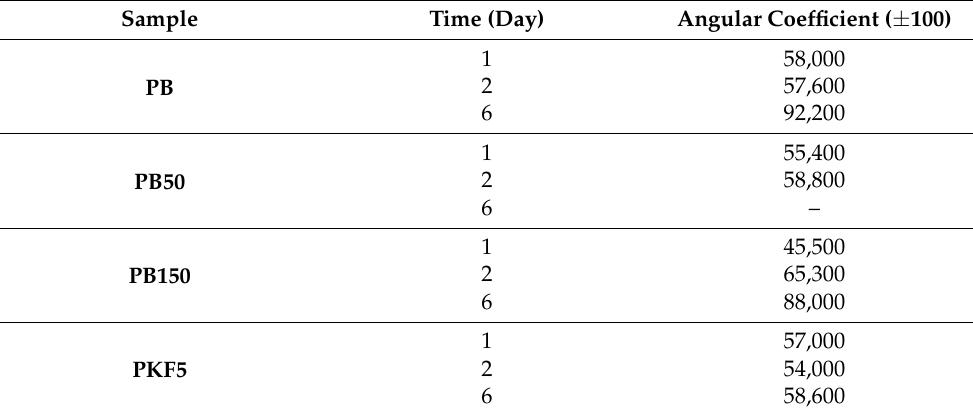
Table 6. Angular coefficient values of bread samples from 1 to 6 days.